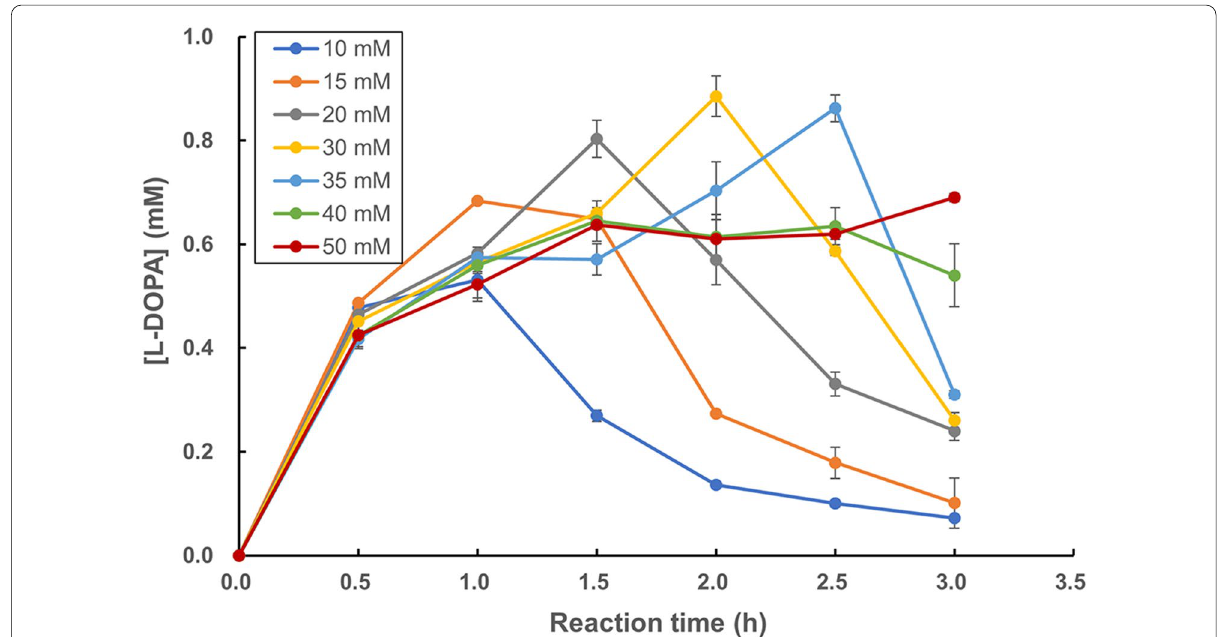
Fig. 7 Effect of l ‑ascorbic acid concentration on production of l ‑DOPA from l ‑tyrosine catalyzed by